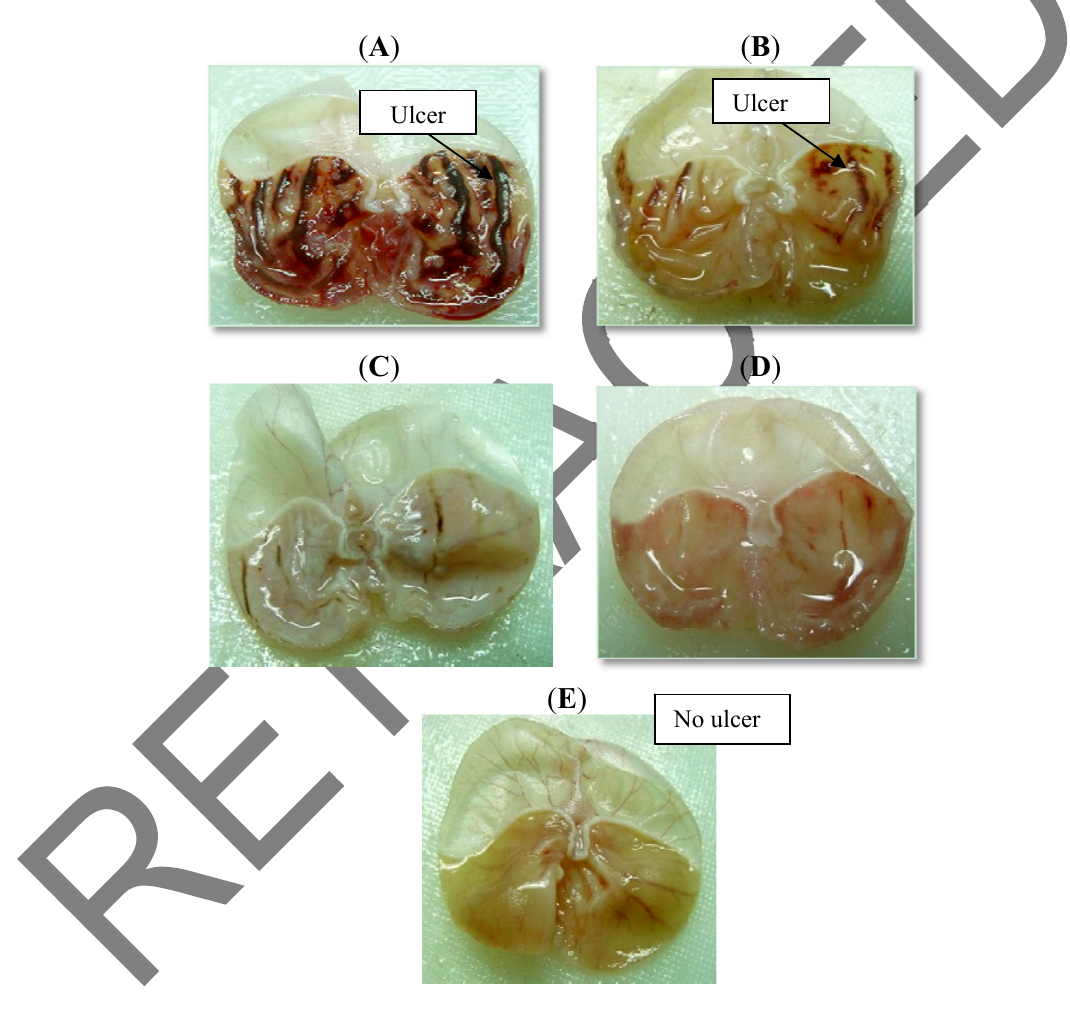
Figure 2. Gross appearance of the gastric mucosa in rat, ( A ) pre-treated with vehicle 0.2 mL of 10% Tween 20 (ulcer control). Severe injuries are seen in the gastric mucosa (arrow).Absolute ethanol produced extensive visible hemorrhagic necrosis of gastric mucosa; ( B ) Rats pre-treated with omeprazole (20 mg/Kg). Injuries to the gastric mucosa are milder (arrow) compared to the injuries seen in the ulcer control rats; ( C ) Rats pre-treated with BClHC (100 mg/Kg). Mild injuries to the gastric mucosa can be seen showing the beginning of gastric mucosa flattening; ( D ) Rats pre-treated with BClHC (200 mg/Kg). Very mild injuries to the gastric mucosa can be seen, showing the flattening of gastric mucosa, ( E ) Rats pre-treated with BClHC alone (400 mg/Kg). No injuries to the gastric mucosa are seen, but the flattening of gastric mucosa can been